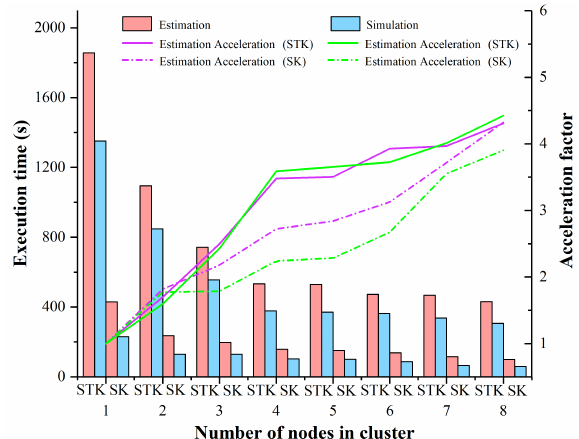
Figure 12. Performance analysis of space K function (denote as SK) and space-time K function (denote as STK) under increasing number of nodes in cluster